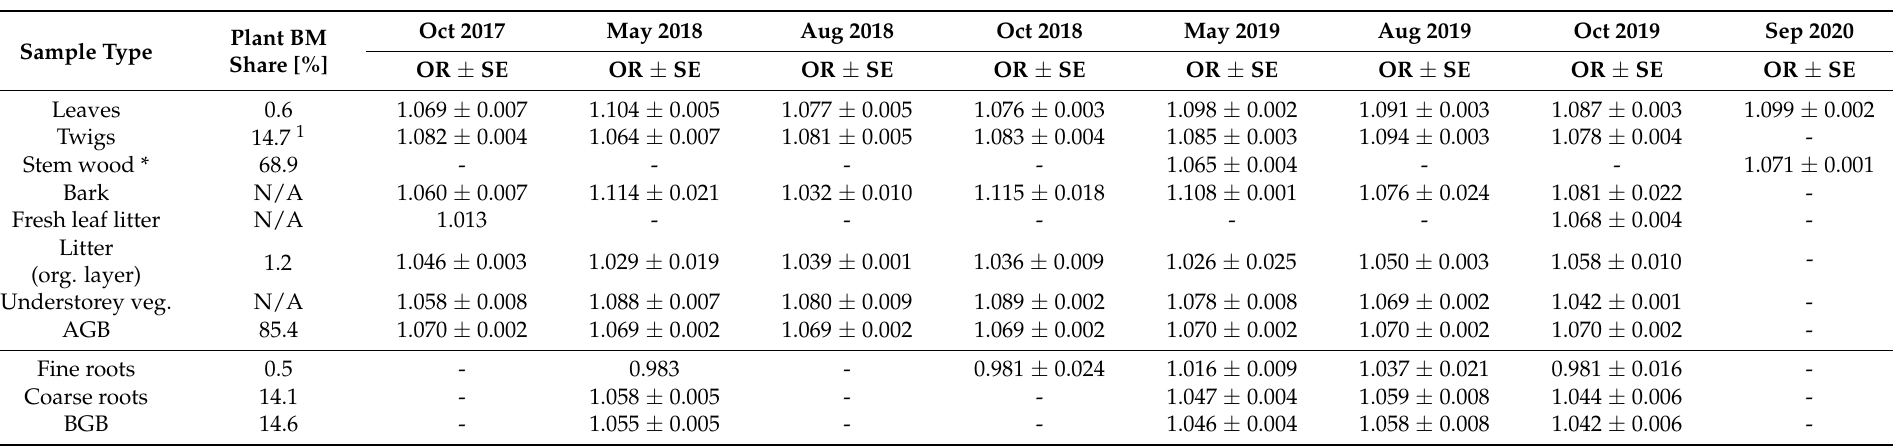
Table 5. Oxidative ratios (mean ± SE) by component and sampling date and biomass